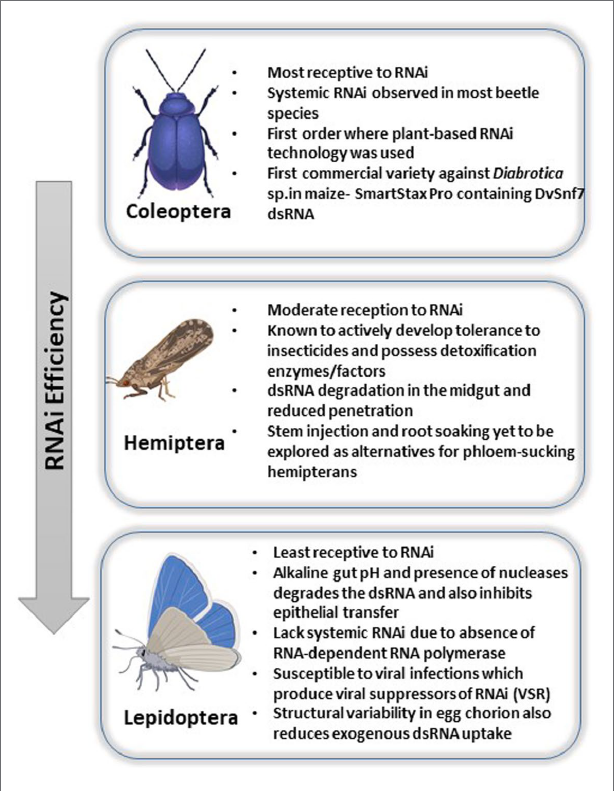
FIGURE 1 | Pictorial representation of RNAi efficiencies and challenges faced across insect orders like Coleoptera, Hemiptera, and